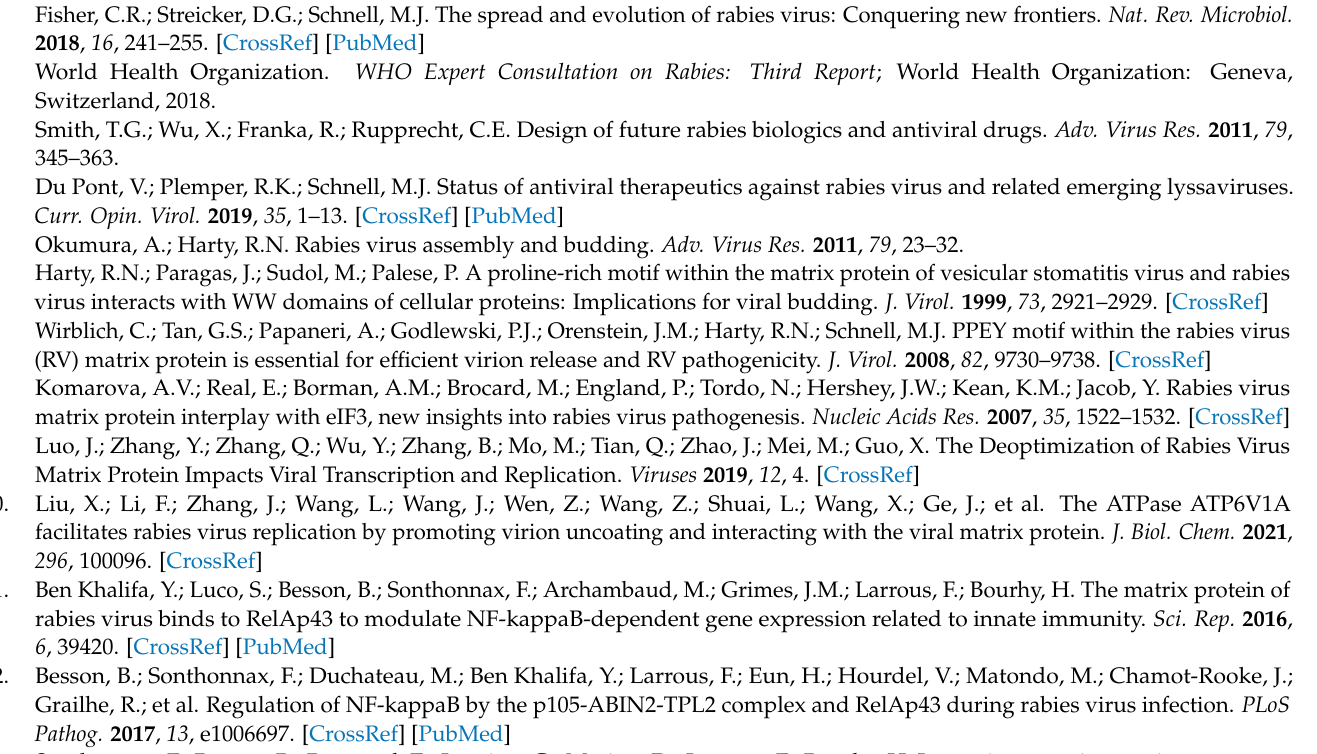
figshare database (https://doi.org/10.6084/m9.figshare.21937601.v1, accessed on 25 January 2023.). All the other relevant data are within the